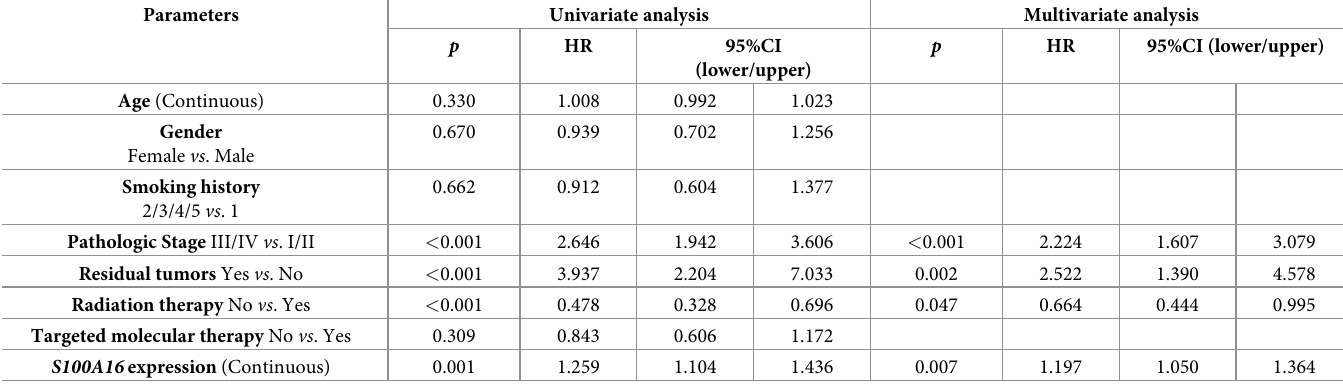
Table 2. Univariate and multivariate analysis of OS in LUAD patients.